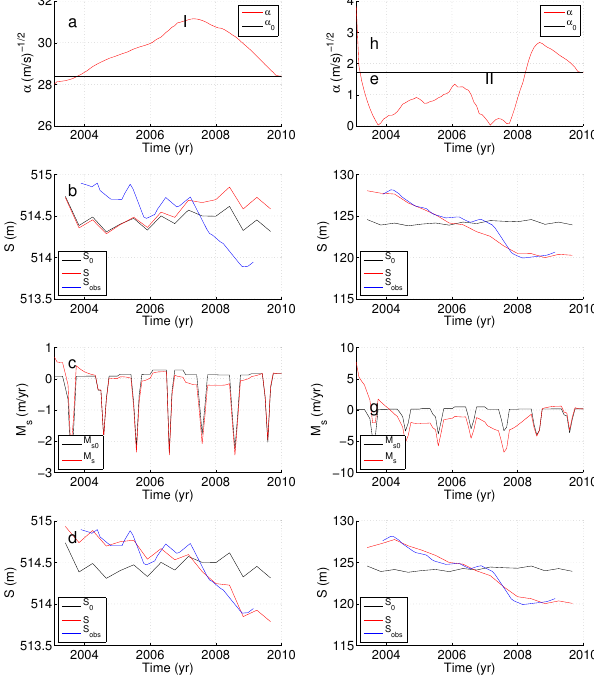
Figure 7. Improvement in the best fit between modeled surface height and the altimetry record after inversion of basal friction α and surface mass balance M s for the two locations indicated in Fig. (3f), corresponding to the center of 79 North (a–d) and a location near the grounding line of Zachariæ Isstrøm (e–h) . (a) and (e) show the difference between the original time series α 0 of friction (in black) and the inverted one α (in red). (b) and (f) show the improvement in the modeled surface height (in red) best fit to observations (in blue) compared to the original model (in black). (c) and (g) / (d) and (h) show similar results as for (a) and (e) / (b) and (f) , with sur- face mass balance M s being the quantity inverted for instead of α . Errors in observed surface height time series for locations I and II, which are below the ELA, depend on the SERAC processing only (ice is assumed fully dense, with no firn compaction involved) and are estimated respectively at 8cm and 1.2m.